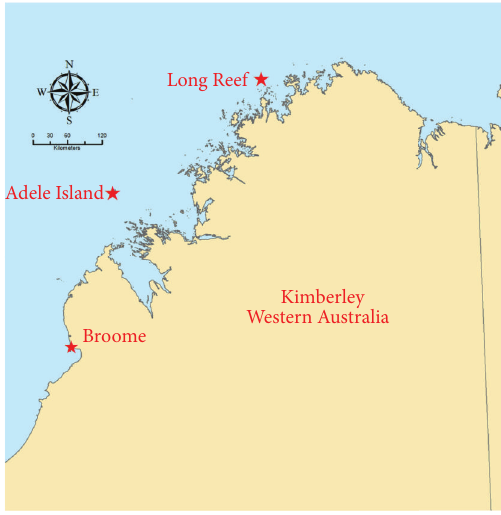
Figure 1: Map of the Kimberley coastline marking the location of Adele Island and Long Reef.